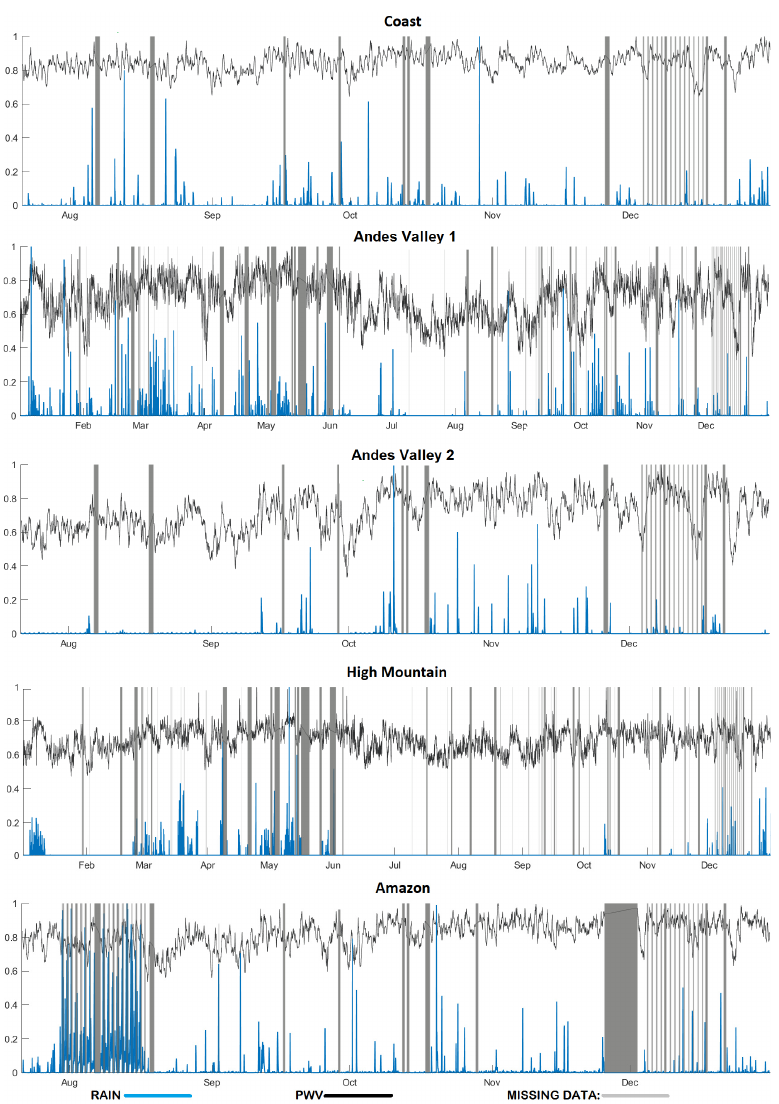
Figure 2. Normalized time series of rain and PWV after data conditioning in 2014. Missing data is shown in gray (See Table 3 for